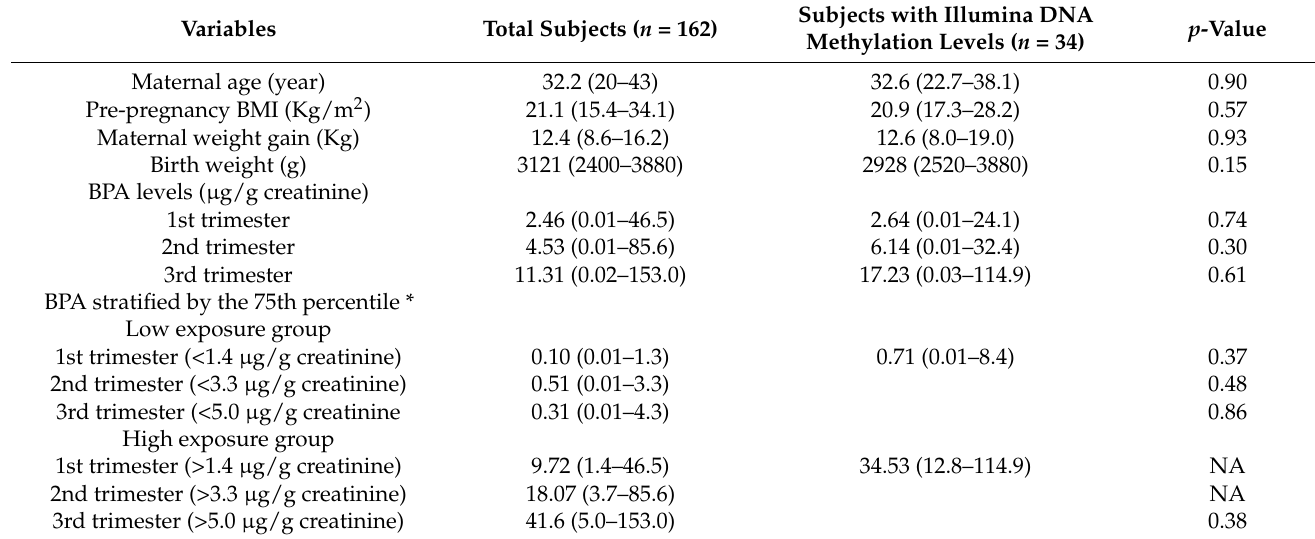
Table 1. Population characteristics (Mean